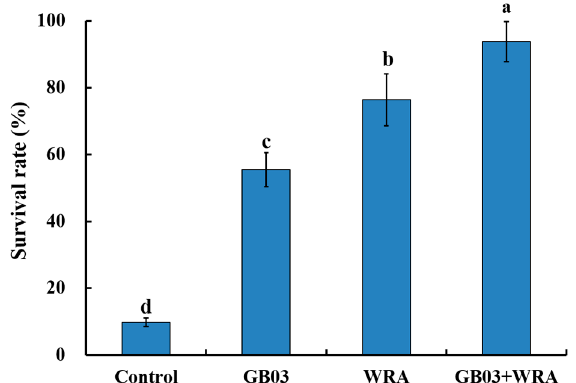
Figure 2. The survival rate of ryegrass seedlings with 20 days natural drought and then seven days after rewatering. Values are means and bars indicate standard errors (SEs) ( n = 12). Columns with different letters indicate significant differences among treatments at p < 0.05 (ANOVA and Duncan’s post-hoc multiple comparison test). Table 1. Soil water content after 20 days of natural drought. Values are means with SEs ( n = 12). Different letters indicate significant differences among treatments at p < 0.05 (ANOVA and Duncan’s multiple range test).